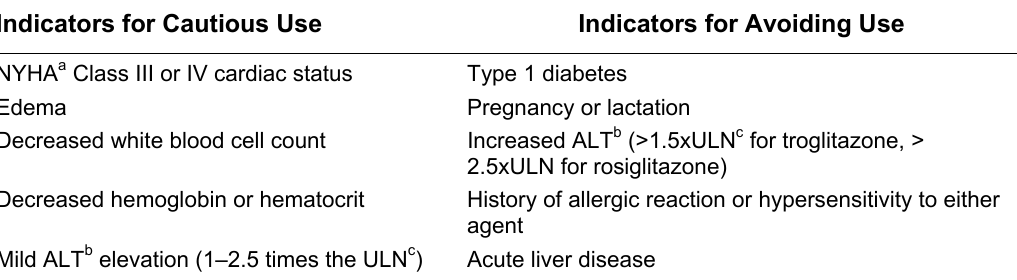
Indicators for Cautious Use or